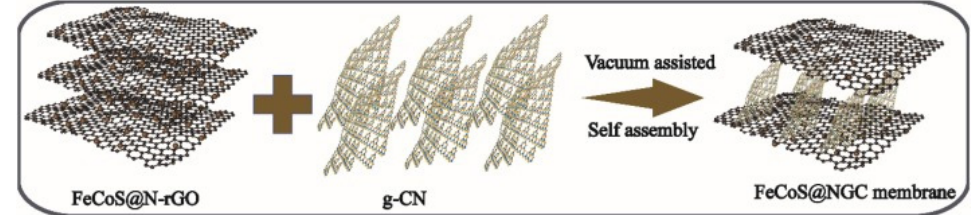
Figure 18. The self-assembly process of FeCoS-NGC membrane, scheme taken from [158].